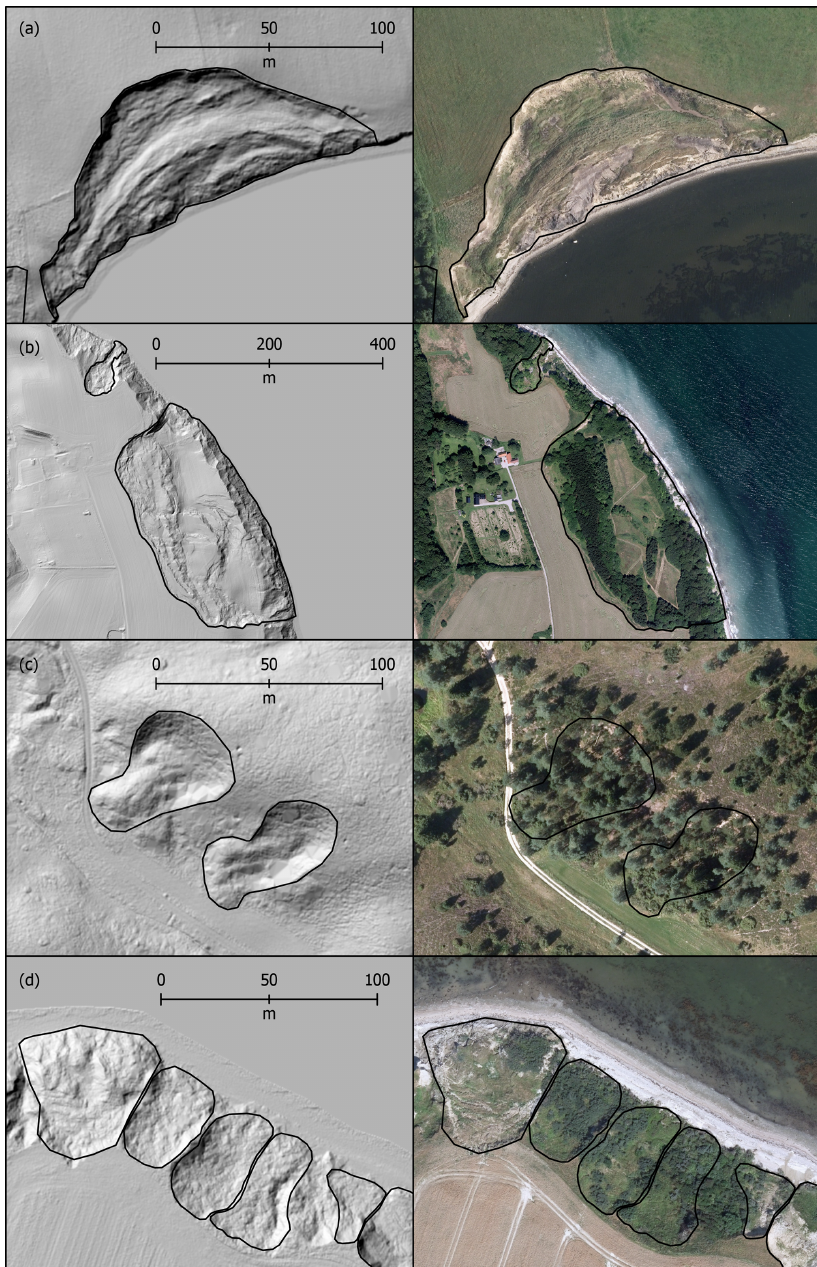
Figure 2. Examples of mapped landslide polygons in the hillshade model (left) and orthophoto from 2015 (right) (Geodatastyrelsen, 2015a, b). Shallow coastal slide (a) , coastal flow and deep-seated slide partly obscured by agricultural land use (b) , two shallow inland slides visible in the hillshade model but covered by vegetation in the orthophoto (c) and the sequence of coastal landslides with different ages and succession rates of